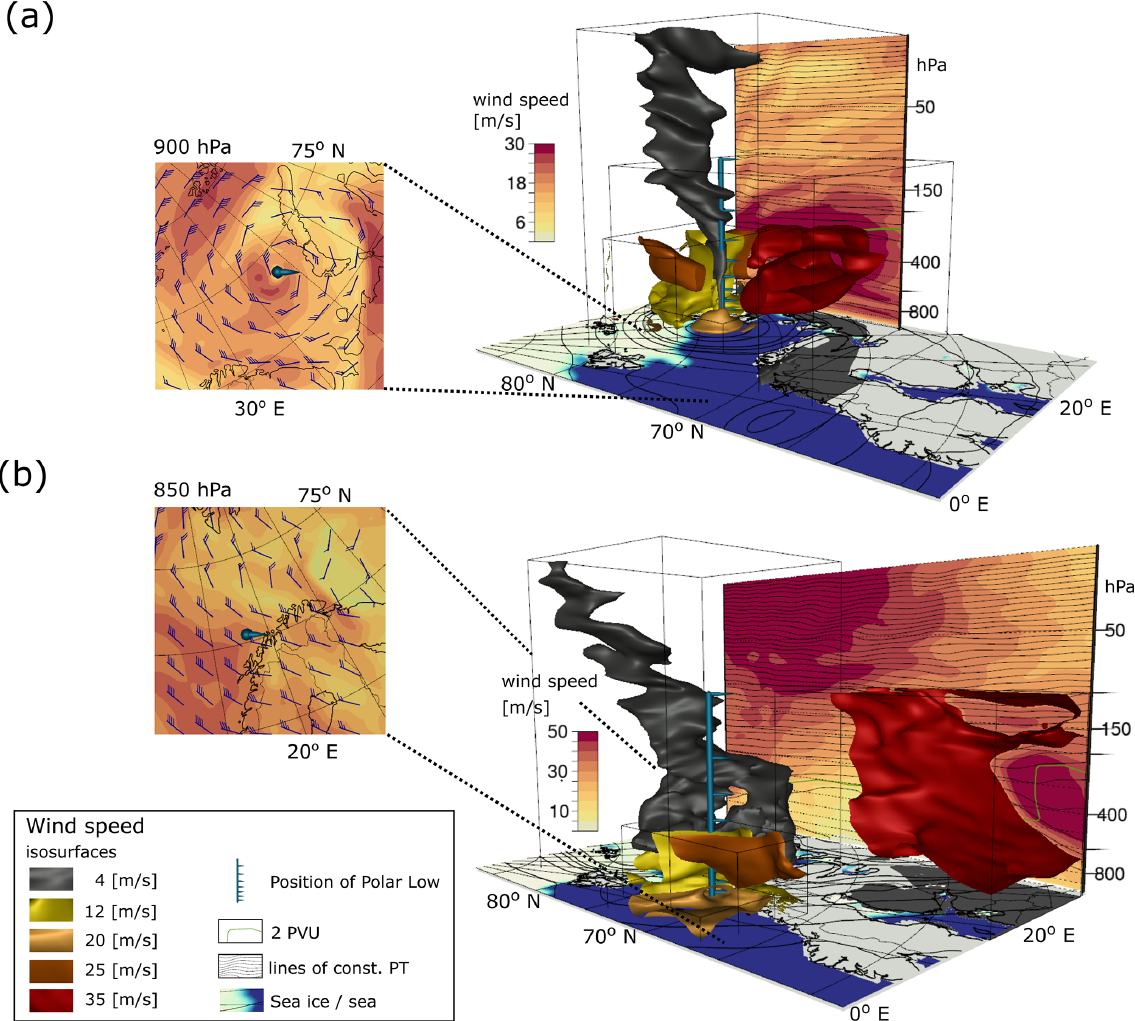
Figure 2. Three-dimensional interactive visual analysis of PLs in ERA5 data. Winds are visualized for the times of two PLs. (a) In case 1, at 16:00UTC on 19 December 2002, a symmetric slow wind “eye” is observed (grey isosurface) in the area where a PL is reported (Bracegirdle, 2012; Føre et al., 2012), with a pronounced vortex in the wind field around it (see inlay). The coherent volume of air with slow winds extends up into the stratosphere. Winds in the lower troposphere are visualized by means of isosurfaces constrained to different bounding boxes for selective illustration of various wind speeds in different volumes of air. Movie 2 demonstrates the interactive 3-D data exploration of PL case 1 using Met.3D. (b) In case 2, at 11:00UTC on 24 March 2011, no symmetric slow wind eye is observed in the lower troposphere in the area of the reported PL (Noer et al.,